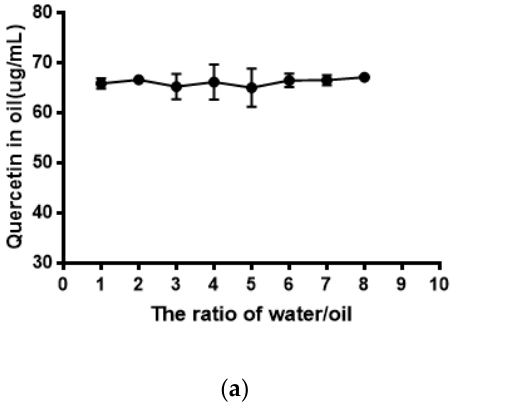
Figure 6. ( a ) Quercetin in oil; ( b ) Quercetin in water.